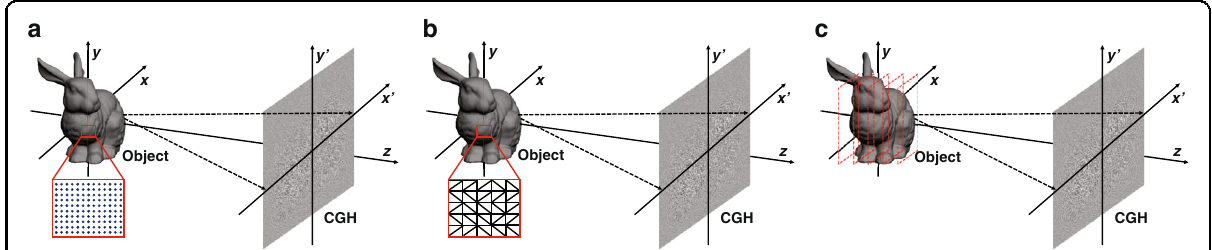
Fig. 3 Diagram of CGH calculation method. a Point-based method; b polygon-based method; c layer-based